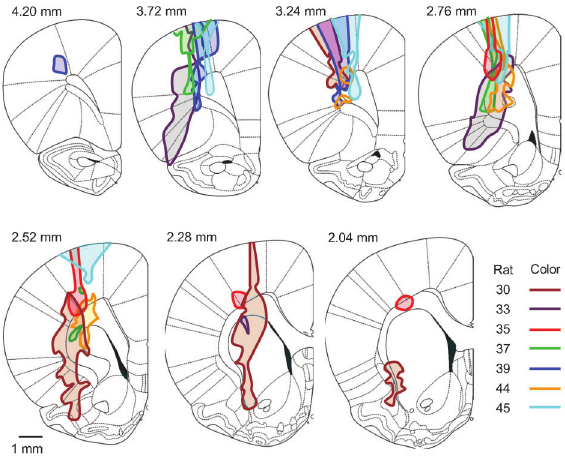
Figure 5. Maximum treadmill speed attained during the three incremental-speed exercise sessions. Initial exercise was con- ducted prior to any surgical procedure in both groups. Animals with a brain guide cannula (operated group) were tested with or without thermistor insertion in a counterbalanced order. The control animals (not operated) were subjected to second and third incremental exercise sessions. Data are reported as means±SE and were analyzed using two-way ANOVA.